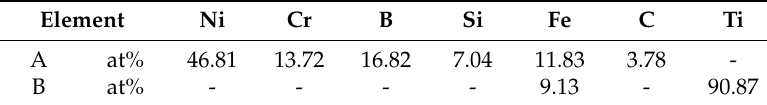
Figure 1. Morphologies and XRD patterns of ( a , b ) Ni60B and ( c , d ) Ti powders. Table 2. Energy dispersive spectroscopy (EDS) analysis of powders.